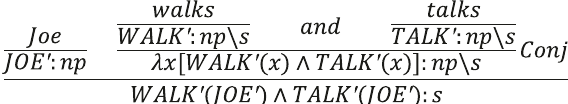
Figure 2: Type Logical derivation of